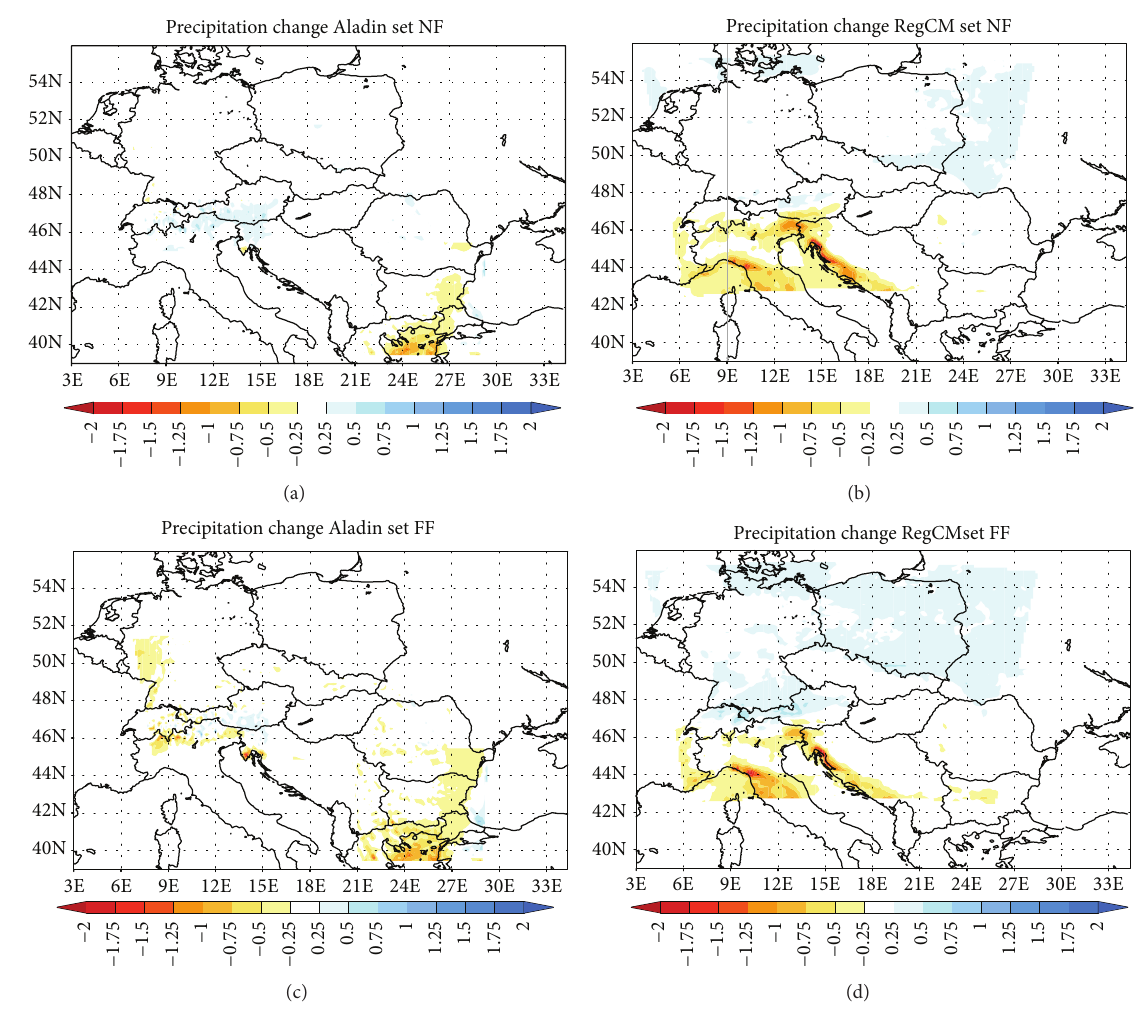
Figure 9: Change in total precipitation in Aladin (a, c) and RegCM (b, d) set between 2021–2050 and 1961–1990 (a, b) and 2071–2100 and 1961–1990 (c, d). Units are mm/day.